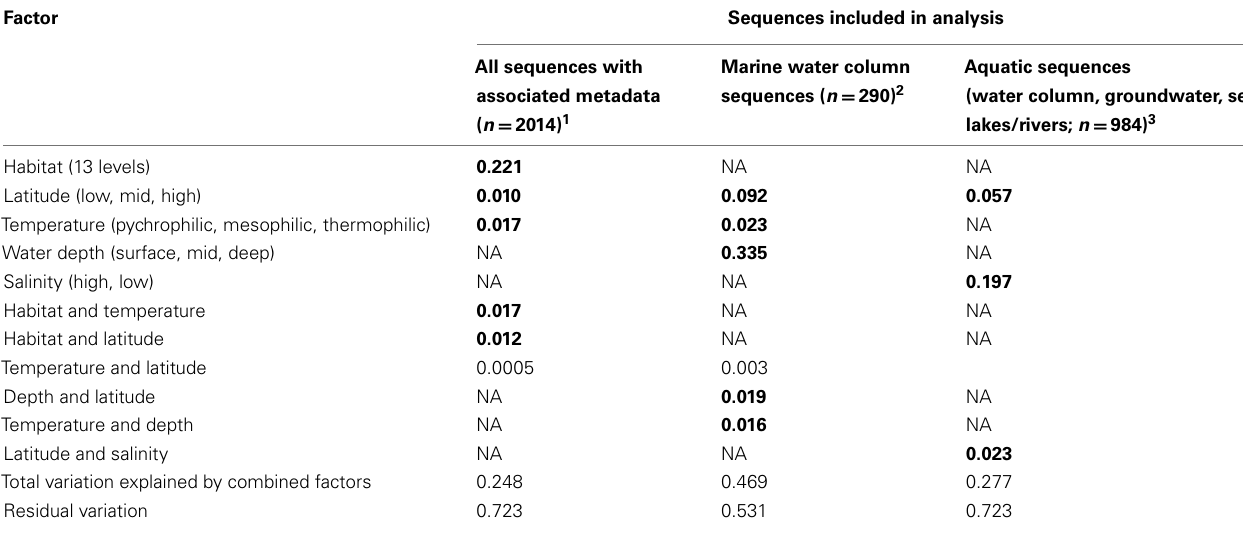
Table 3 | Environmental determinants of archaeal amoA sequence